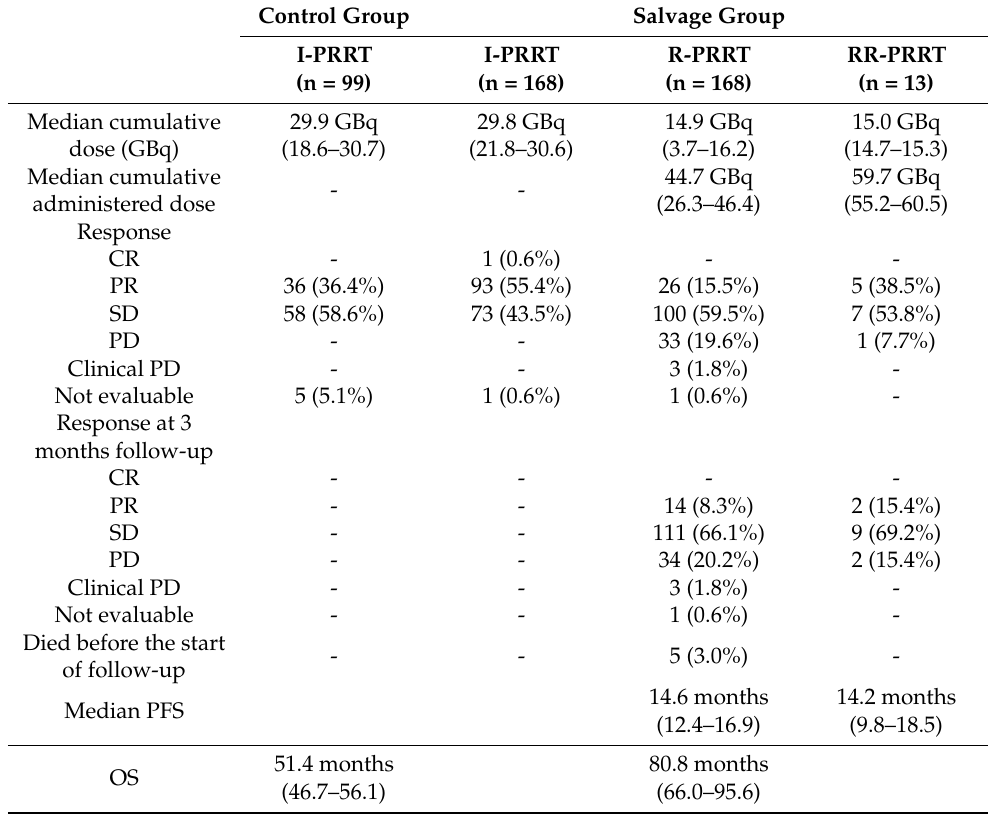
Table 7. Overall results presented in the retrospective study of Van der Zwan et al.